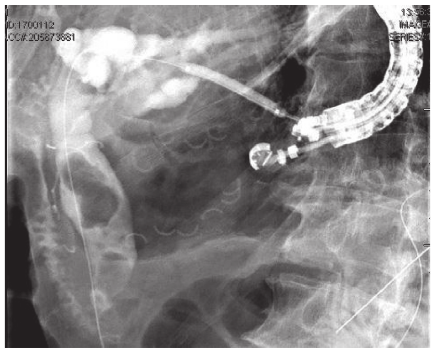
Figure 4: Balloon dilation of the HG tract.